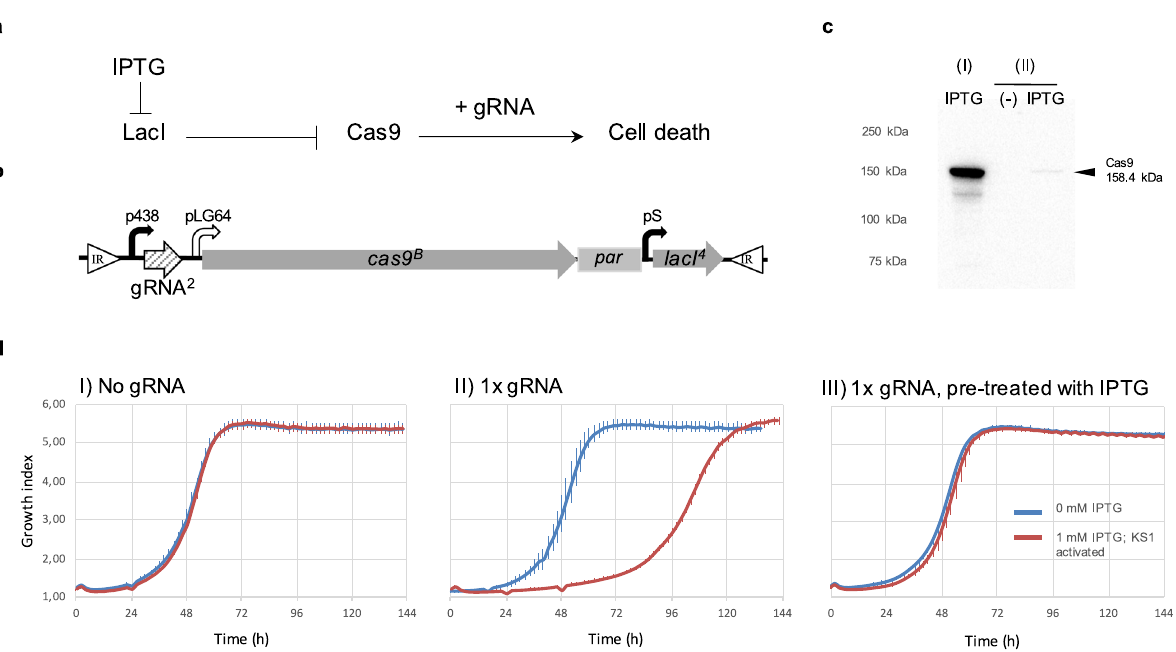
Fig. 2 Design and characterisation of the kill-switch KS1. a Schematic representation of the kill-switch KS1. Blunt arrows indicate repression and pointy arrow activation. b Schematic representation of relevant DNA segments of the MTn par with the KS1 used to generate a polyclonal strain (puromycin used for selection). White triangles represent the inverted repeats fl anking the fragment of the MTn inserted in the genome of Mycoplasma (IR); Bend-arrows for constitutive promoters (black) and IPTG-inducible (white) promoters. Arrows for genes (grey), gRNA (stripped; gRNA 2 has eight targets in the genome of M. pneumoniae ); par , selection cassette. c Western blot results showing Cas9 expression in strains with the KS1 kill-switch with the cas9 gene with the canonical initiation codon ATG (I) or a CTG codon instead (II). Protein expression was analysed using 10 μ g of total protein extract from pre-induced ( − ) and 1 mM IPTG-induced (IPTG) samples. d Growth kinetics of polyclonal strains with KS1 without any gRNA (I), with a single gRNA copy (II) and same but pre-treated with IPTG in the previous passage (III). Graphs show growth kinetics (growth index corresponding to the ratio Abs430nm/Abs560nm) when KS1 is uninduced (0 mM IPTG, blue lines) or IPTG-induced (kill-switch activated with 1 mM IPTG, red lines). Mean values from three bio-replicates. Error bars indicate standard deviation. Source data are provided as a Source Data fi